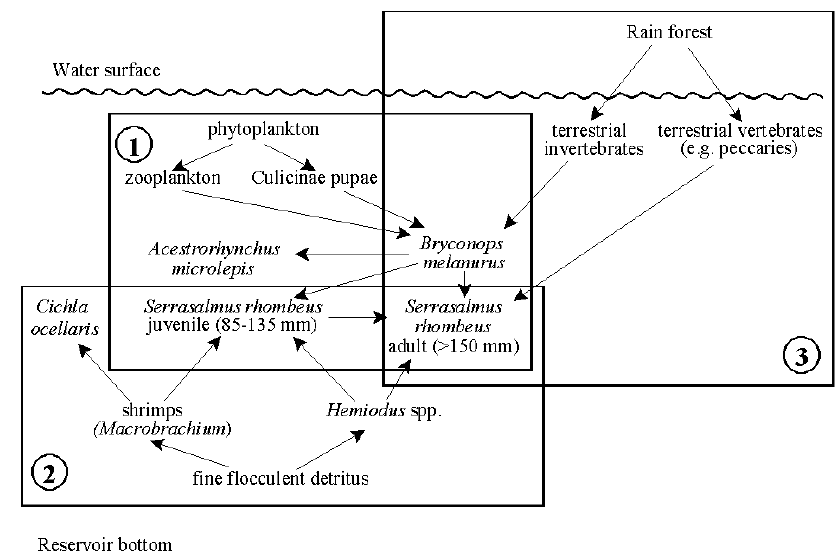
Fig. 2. Food web of the open-water habitat of Brokopondo Reservoir based on fish stomach content analysis. Food chains are based on autochthonous autotrophic production (1), fine, flocculent detritus of unknown origin (2) and, to a lesser extent, allochthonous production of the rain forest (3).